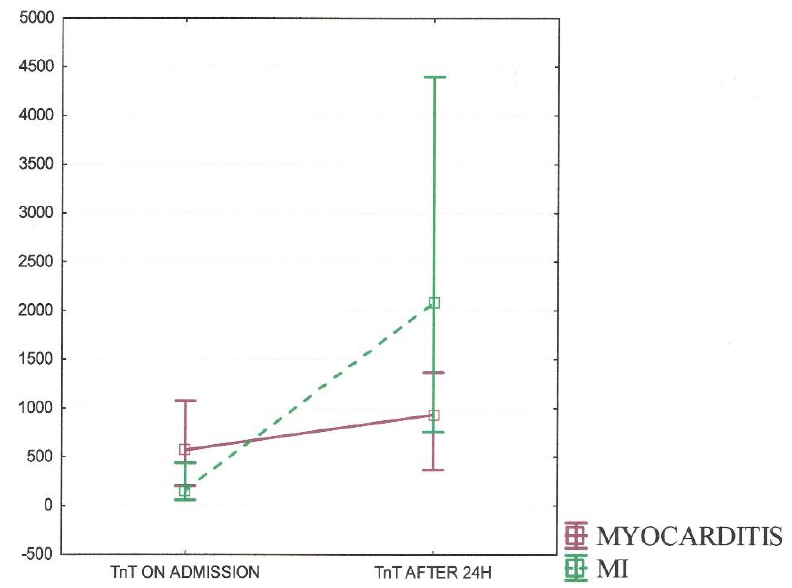
Figure 2. TnT patterns for myocarditis and myocardial infarction including TnT levels on admission and after 24 h.